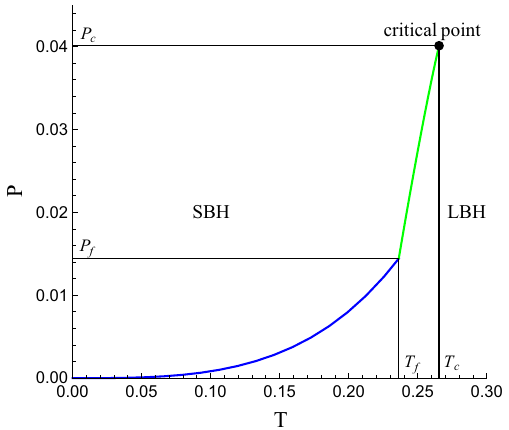
Fig. 5 P – T diagram. The blue and green curves indicate the coexis- tence line of SBH and LBH. On crossing the blue (green) line from left to right or top to bottom, the system goes under a first (zeroth) order phase transition from SBH to LBH